Question: According to the figure, is the described quantity increasing or decreasing?
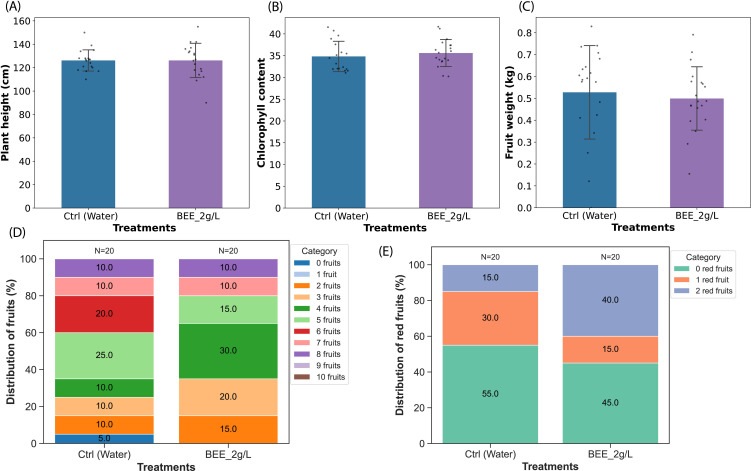
Answer: increasing